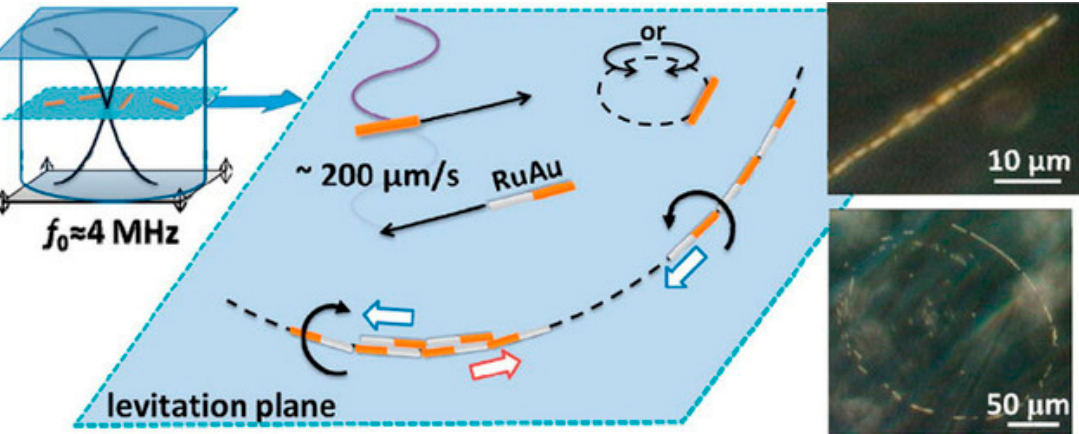
Figure 5. Ultrasonic standing wave powered Au/Ru rods. The figure has been reproduced with permission from the American Chemical Society [163].